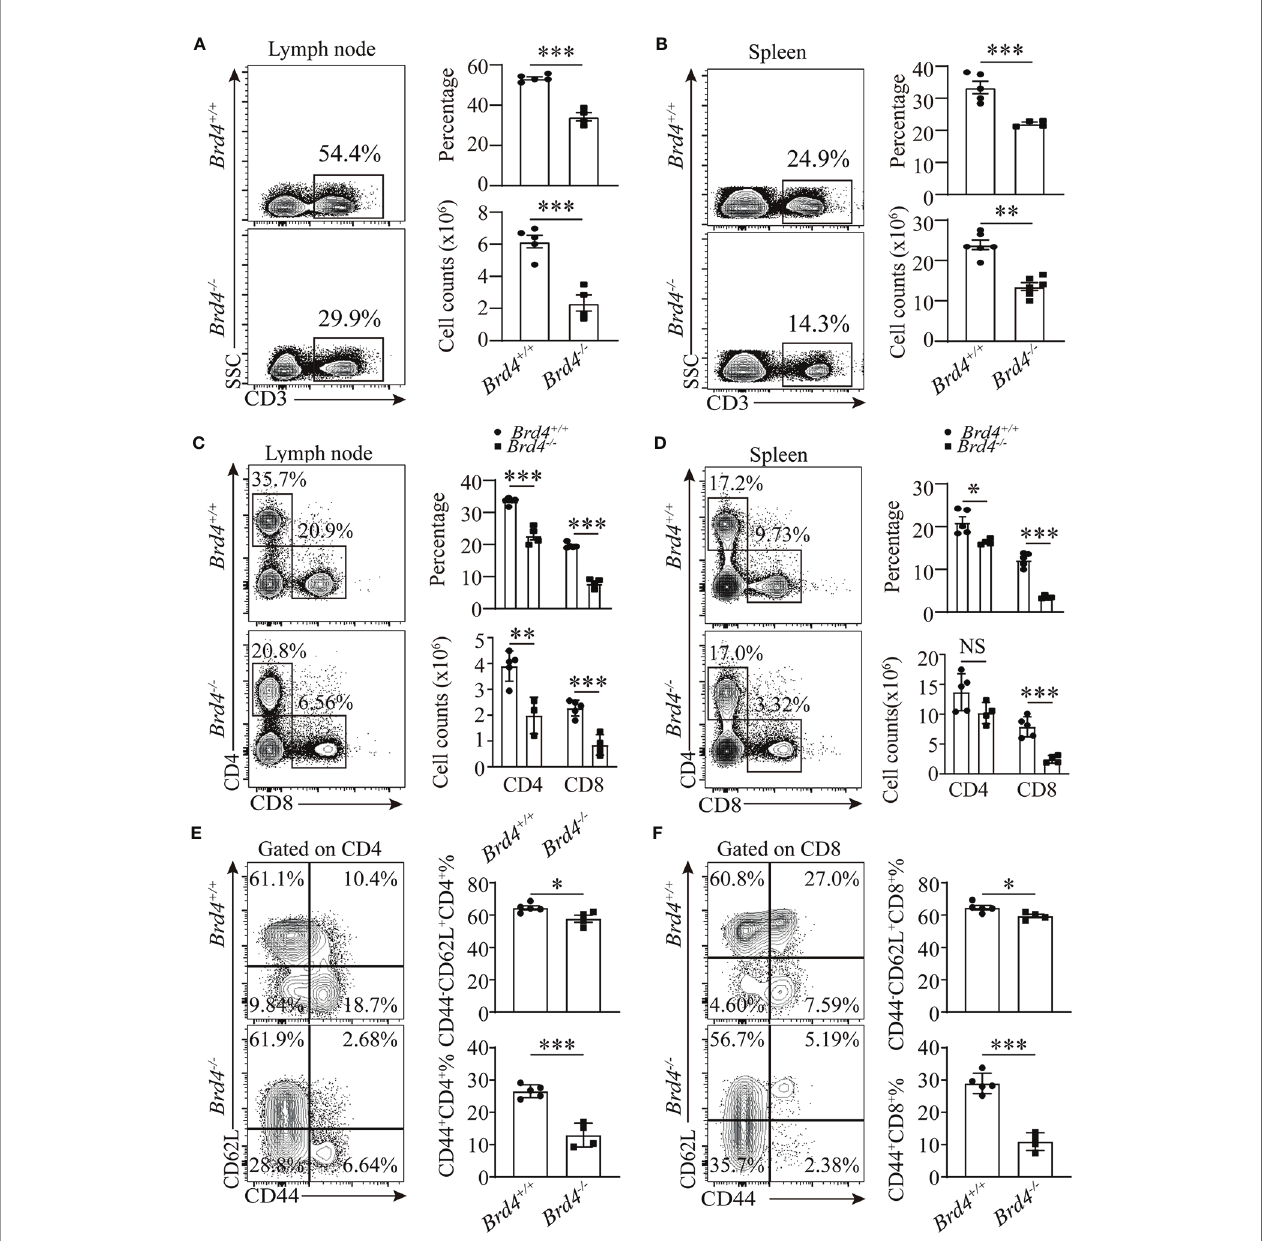
FIGURE 1 | Brd4 is required for peripheral T cells maintenance. (A, B) Flow cytometry showing the expression of CD3 (left) and quanti fi cation of total CD3 + T cells (right) in lymph node (A) and spleen (B) . (C, D) CD4 and CD8 expression determined by fl ow cytometry in lymph node (C) and spleen (D) (left), the absolute number and proportion of CD4 + T cells and CD8 + T cells in spleen and lymph node (right). (E, F) Naïve (CD44 - CD62L + ) and memory/activated (CD44 + ) T cells compartment analysis within CD4 + T (E) and CD8 + T cells (F) from freshly prepared splenocytes. Two-tailed unpaired t-test was used to analyze two independent groups. Results were indicated as mean ± sem (error bars). *p < 0.05; **p < 0.01; ***p < 0.001. NS, not signi fi cant. Each group includes at least 3 mice and each experiment repeats more than 3